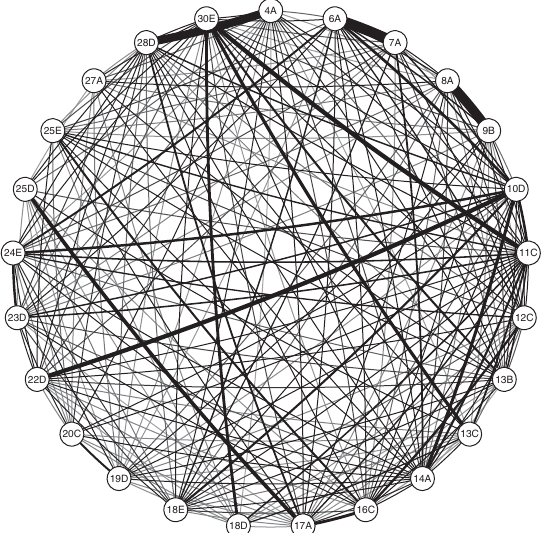
FIG. 3. The network structure of factor 1 items is plotted in a circular distribution. The stronger the correlation the thicker the connecting line, and the colors black and blue represent positive and negative correlations, respectively. For sake of transparency, connections with absolute value less than 0.1 are omitted. While there are connections with strong correlation they only seem to form binary groups, e.g., 6A and 7A, rather than larger cliques. There are, perhaps, two items (10D and 30E), which could play some central role and provide cohesive force for the other items. Otherwise this circular graph seems to be connected in a balanced manner, i.e., lots of items are connected relatively weakly to lots of other items.